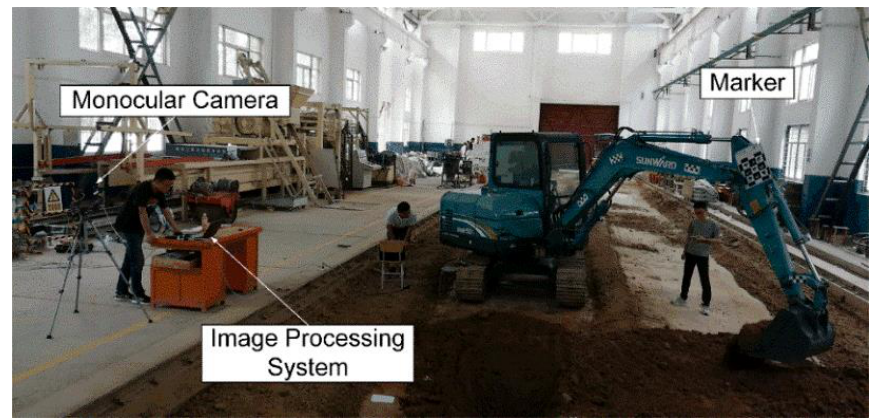
Figure 1. Excavator pose estimation system.